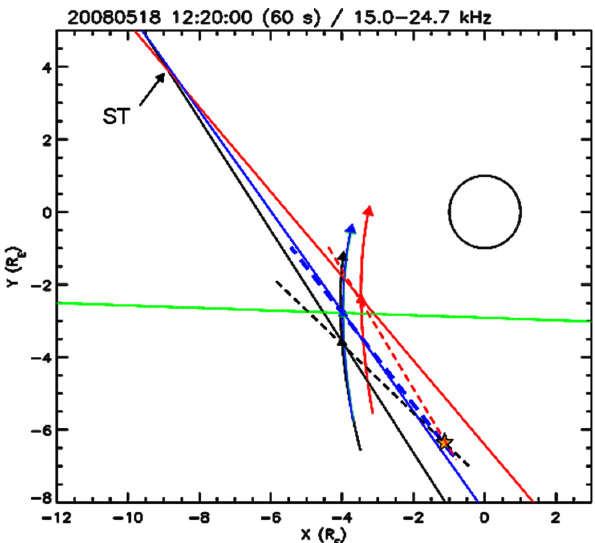
Fig. 8. Source localization by triangulation for the event of 18 May 2008. Orbit elements (curved arrows) and ray paths (solid lines) of a given colour intersect at satellite positions (black for C1, red for C2, green for C3 – see text – and blue for C4), ray paths merging at source position from triangulation, ST, pointed by an ar- row. This plot also displays the position of source (orange star) ob- tained from the 3-D-isoFce approach (see text and Fig. 9), dashed lines showing associated source to satellite ray paths projected unto the XY GSE